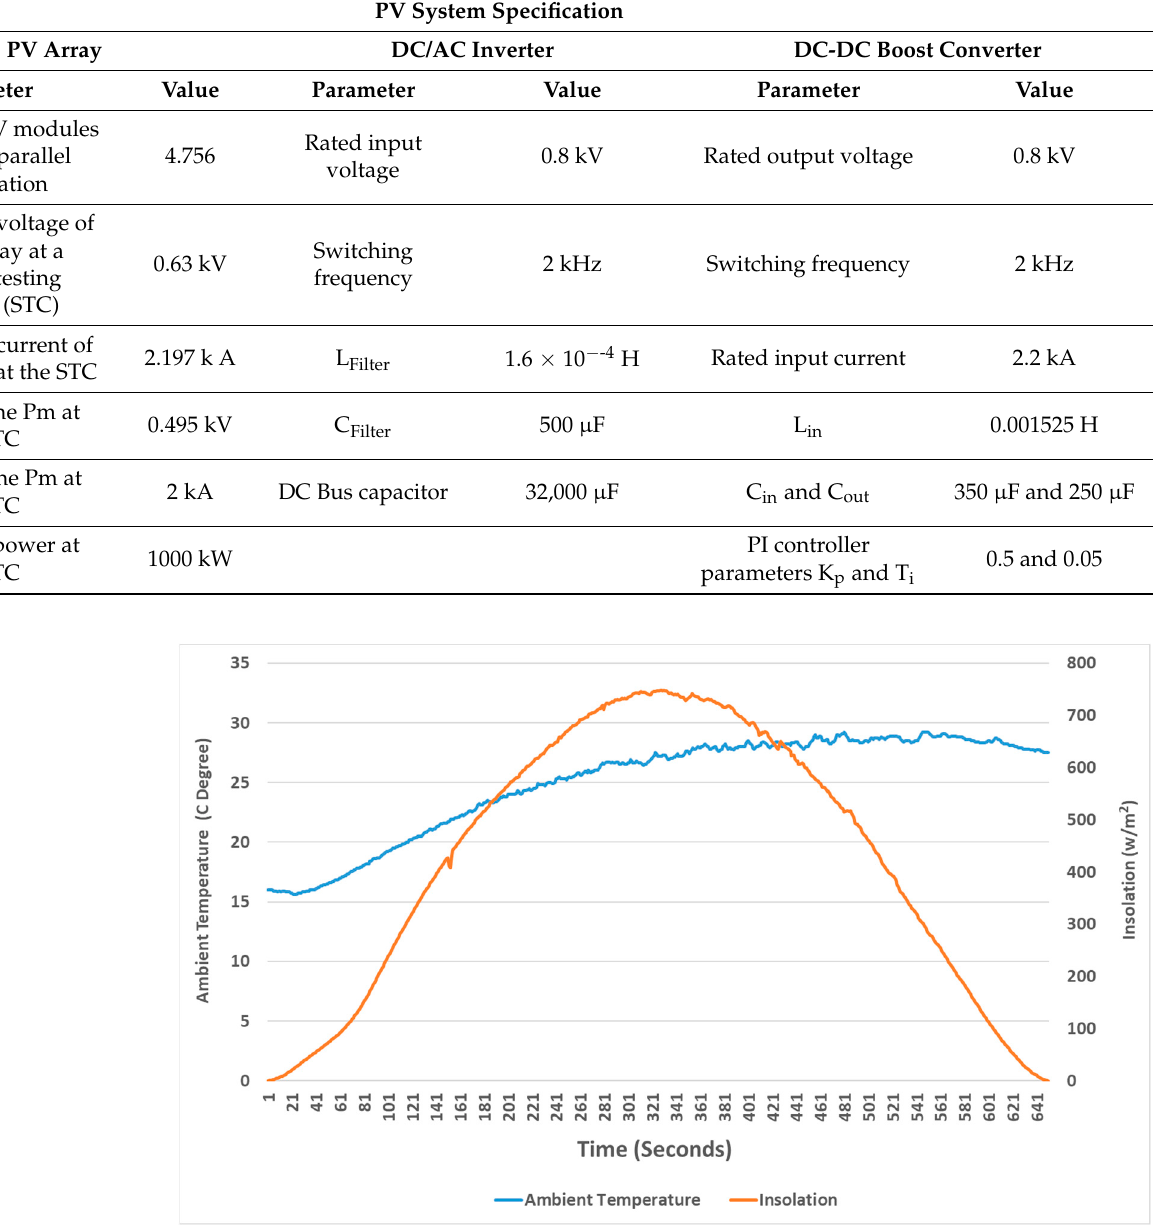
Figure 4. Curves of the actual insolation and ambient temperature for a clear day. Table 2. Parameters of the PO-MPPT and the proposed